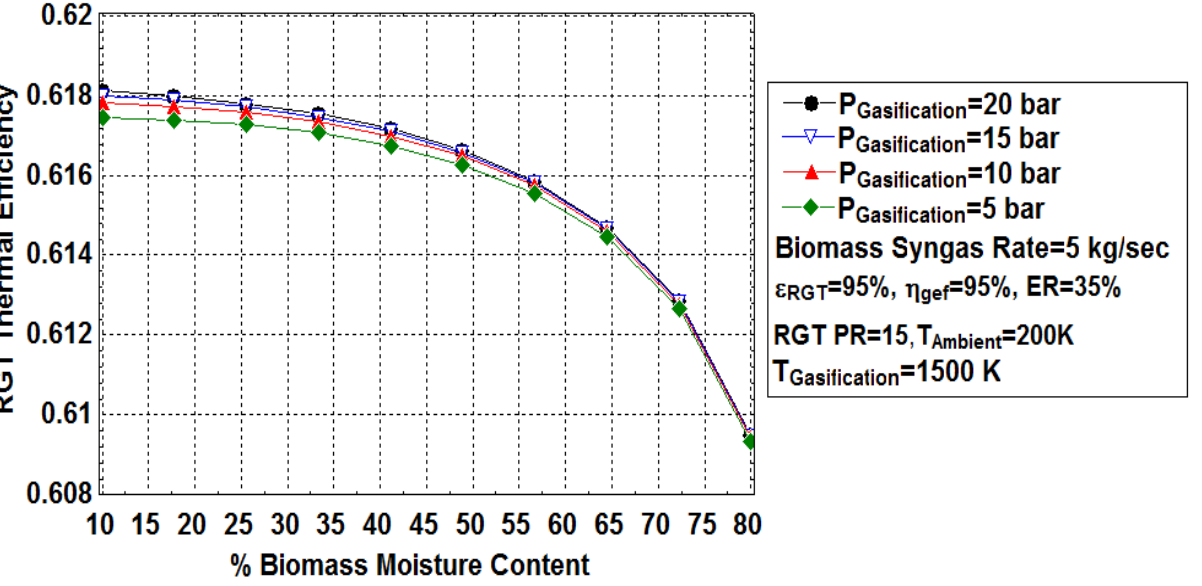
Figure 3. Variation of biomass moisture content with RGT thermal efficiency at different gasification pressures.